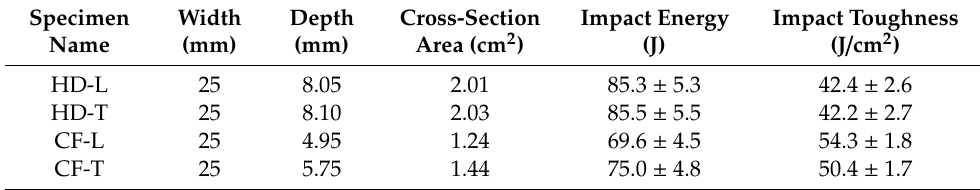
Table 3. Impact properties with average ± standard